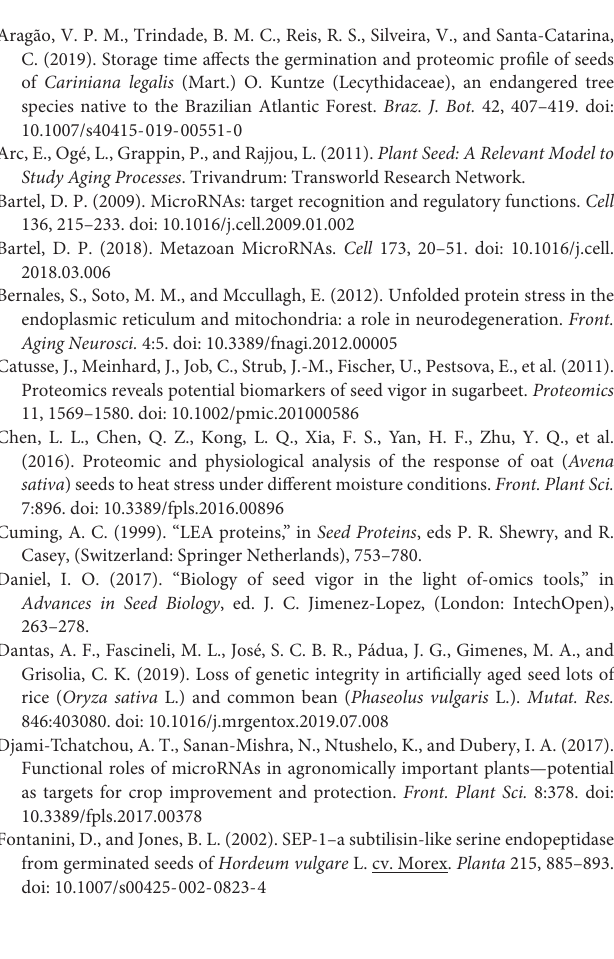
Supplementary Table 2 | Distribution of gene transcript levels in various rice seed samples.